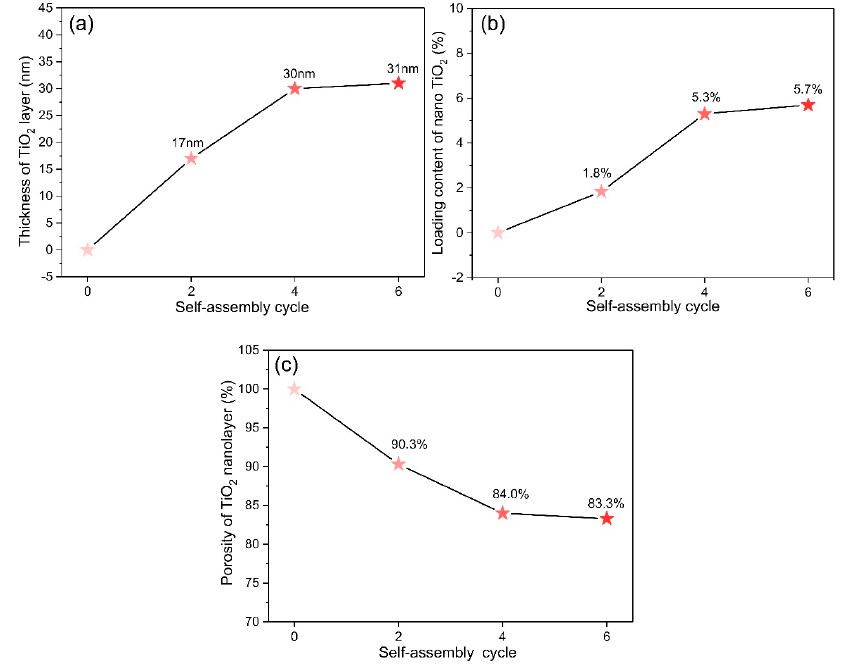
Figure 4. ( a ) Thickness; ( b ) assembled content, and ( c ) porosity of the TiO 2 -coated electrospun fibers with different self-assembly